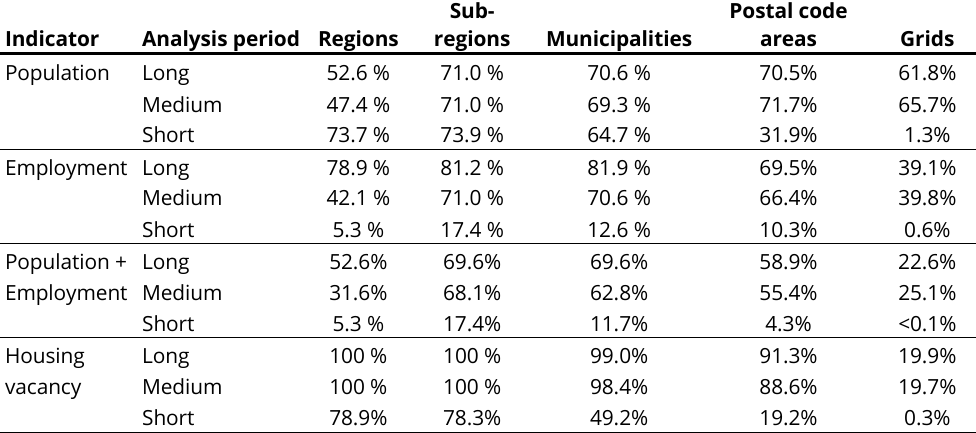
Table 2. Shares of shrinking Finnish regions per indicator, spatial scale and analysis